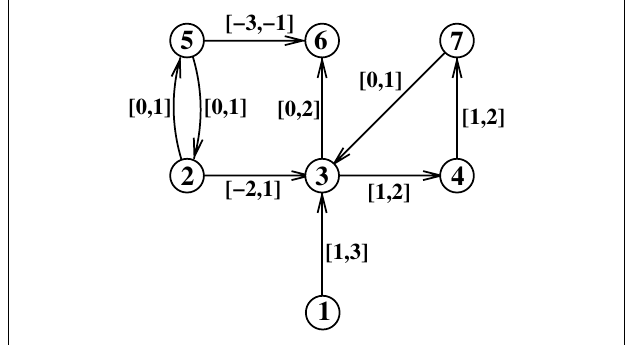
, v , v , v , v , v , v and edge 1 2 3 4 5 6 7